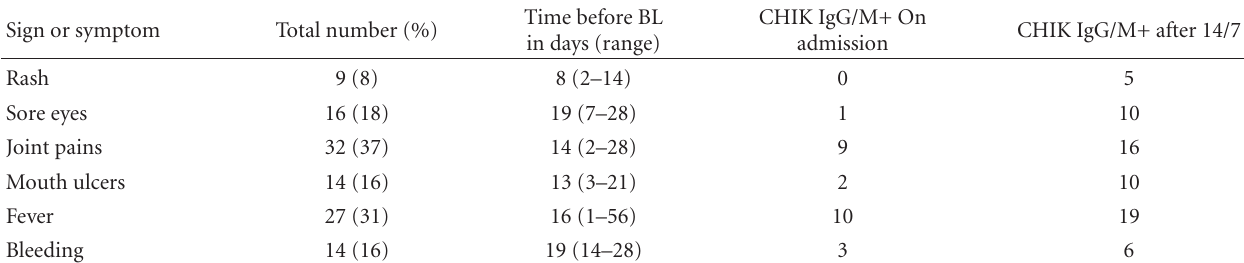
Table 3: Characteristic arboviral signs and symptoms seen in eBL patients immediately preceding development of lymphoma. Sign or